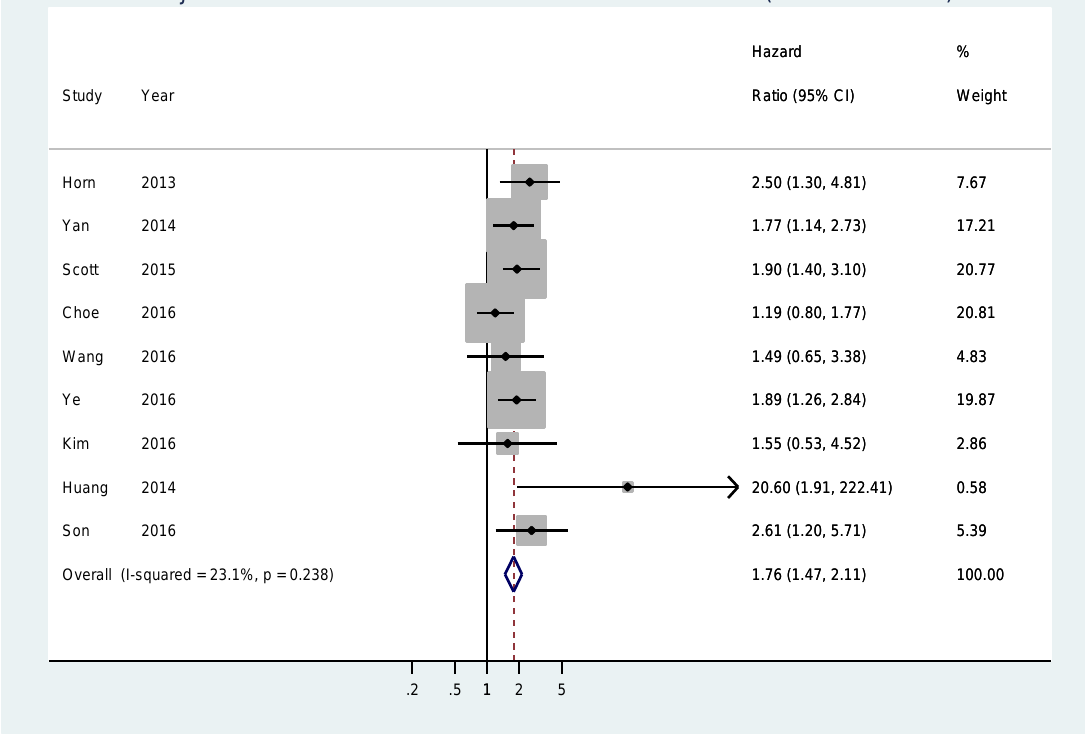
Figure 2. Forest plot showing the meta-analysis of adjusted hazard ratio estimates for overall survival (OS) in patients with MYC overexpression.